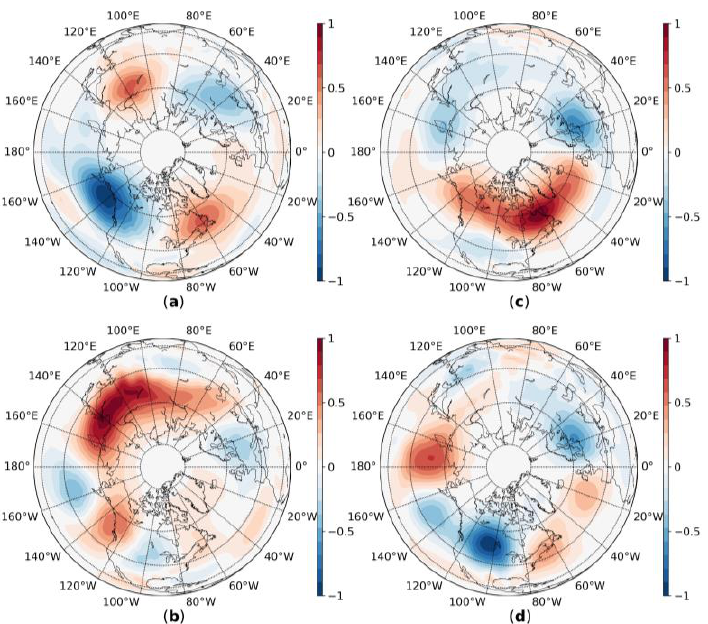
Figure 8. The spatial structure of the first ( a , c ) and second ( b , d ) empirical orthogonal functions of the vertical component of the Plumb flux (first and second EOF Fz) obtained from the EN ( a , b ) and LN ( c , d ) experiments at the 100 hPa level.